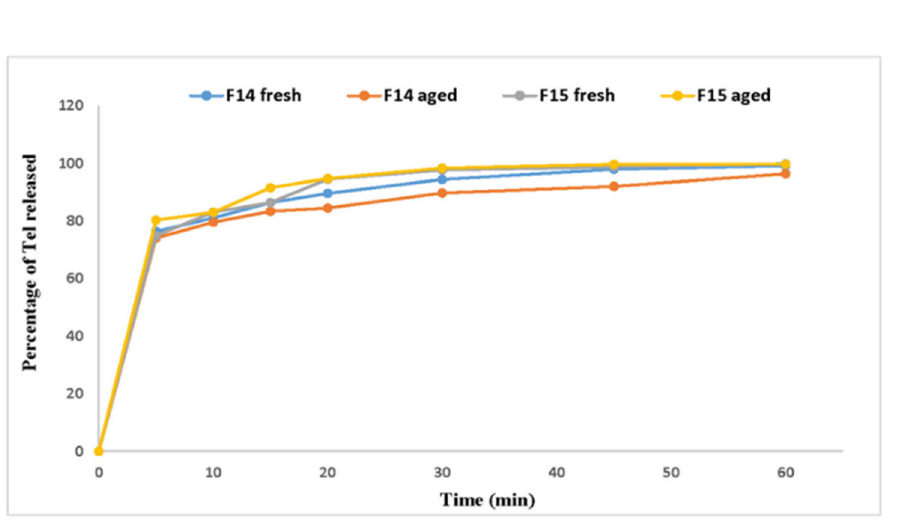
Figure 7. Dissolution profile of fresh and aged formulae.